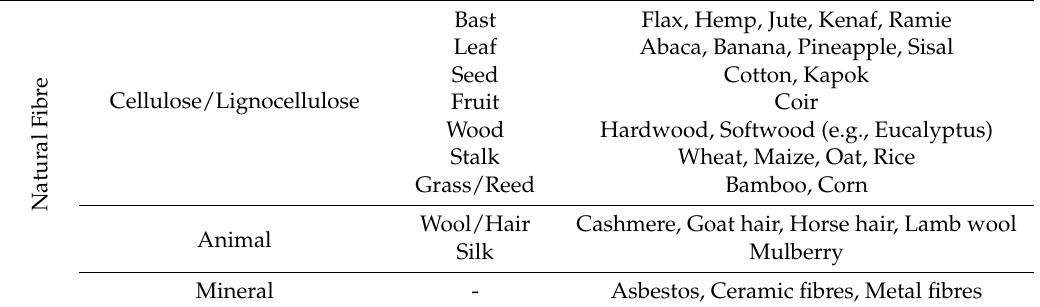
Table 2. Natural Fibre Classification. Adapted from: